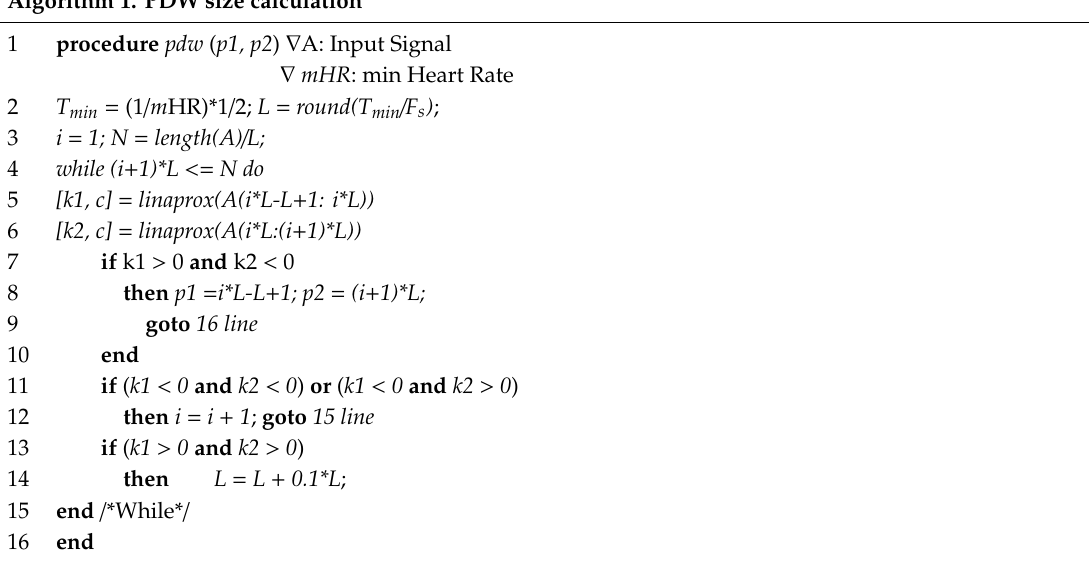
Algorithm 1. PDW size